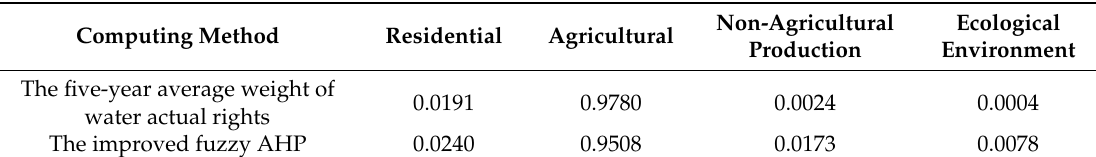
Table 4. The weight of initial water rights in different industries. Table 3. The weight of initial water rights in di ff erent industries.